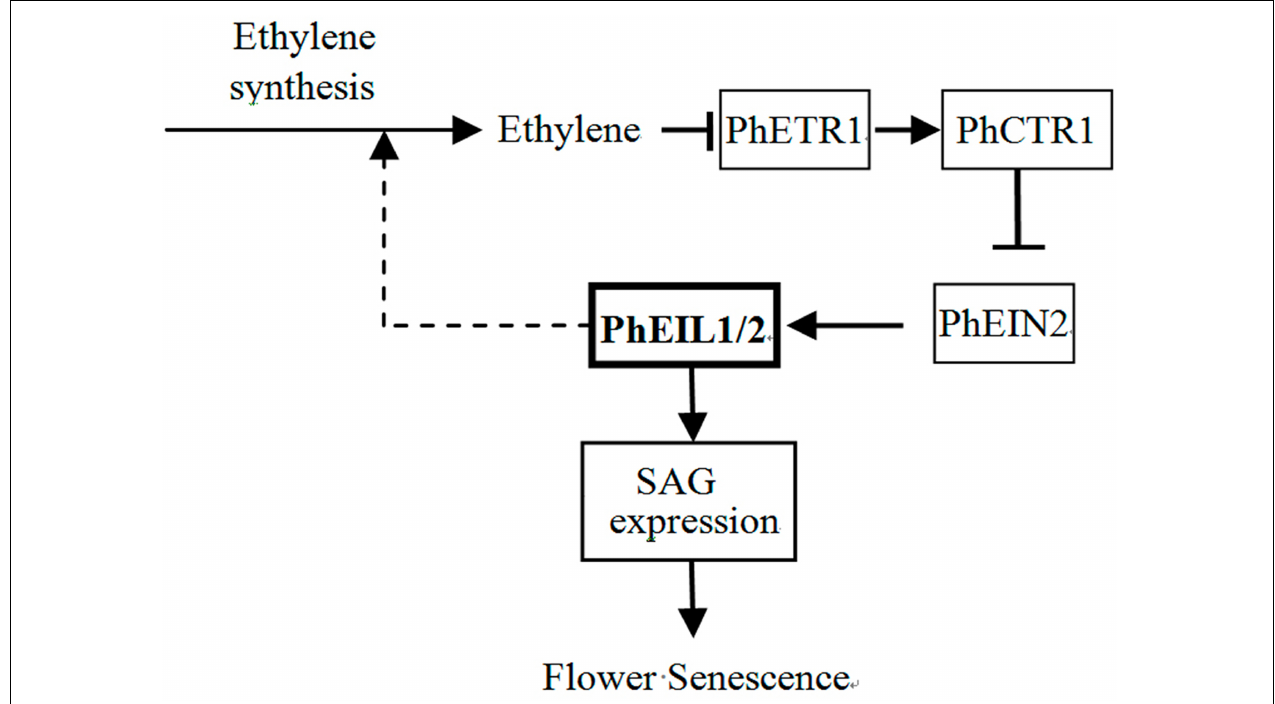
FIGURE 8 | Proposed models for the involvement of PhEIL1 and PhEIL2 in flower senescence in